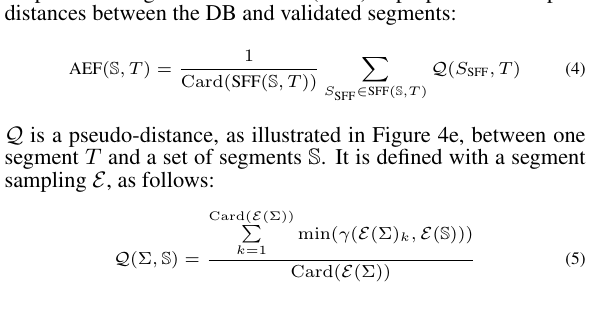
In our paper, θ is empirically fixed to 20 o , which is a hard thresh- old to delete non-matching segments.